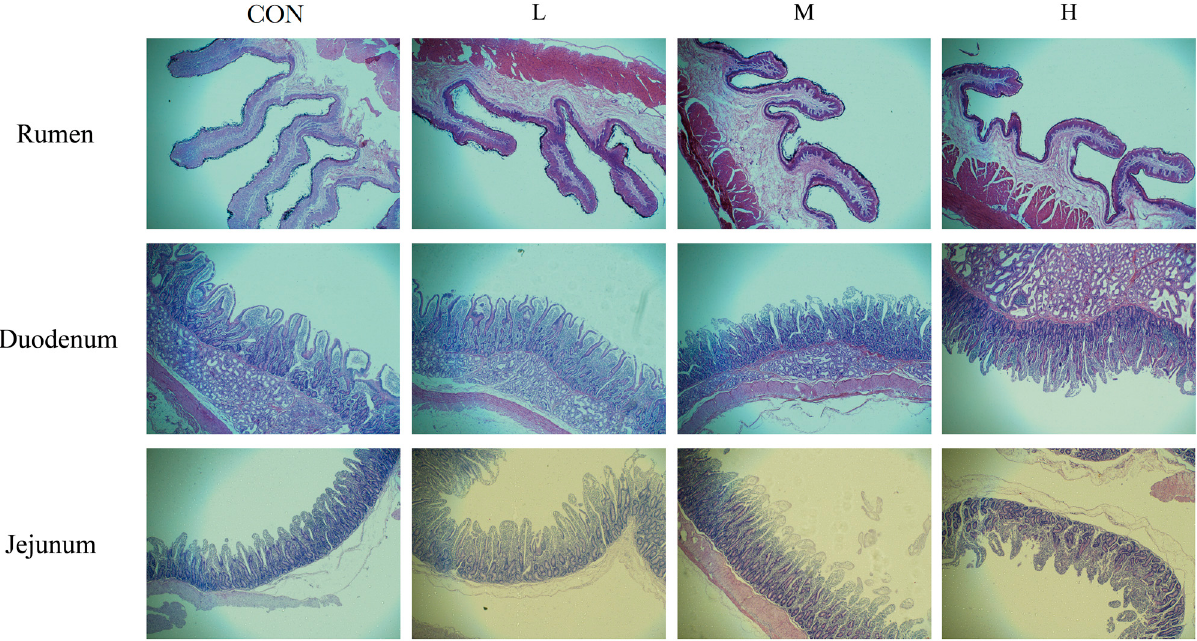
Figure 1. Histological observation the lambs’ rumen, duodenum and jejunum tissues. CON, L, M and H represent the substitution of 0, 20, 40 and 60% of maize silage with mulberry silage, respectively.